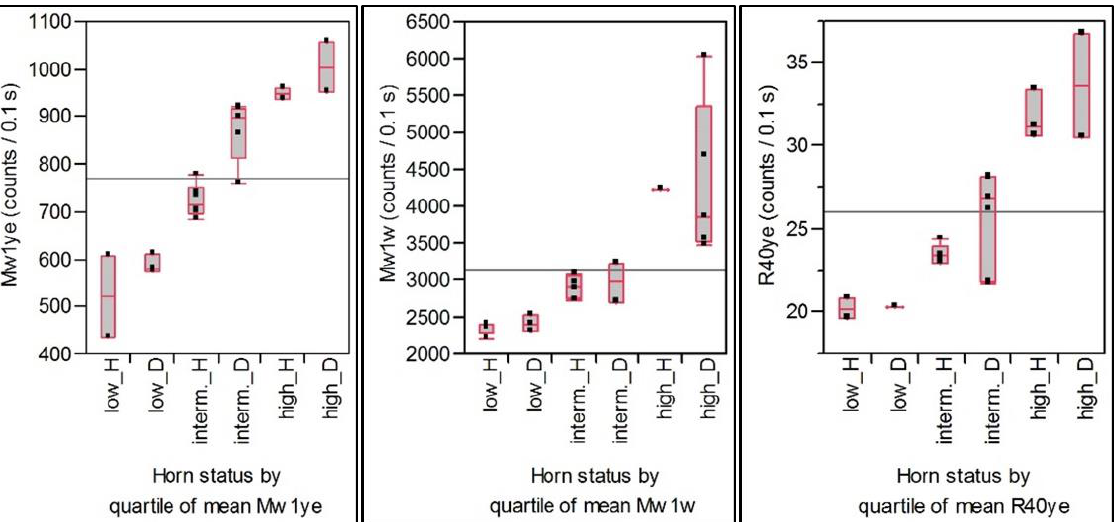
Figure 2. Mean emission of the cow in relation to the horn status and the quartile group of the respective EP, for Mw1ye, Mw1w, and R40ye. Box plots indicate the median and by the whiskers the upper and lower quartile region of non-outlier data per group. H = horned, and D = disbudded.